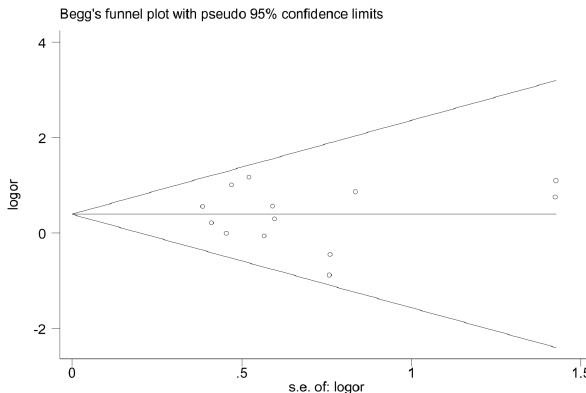
Figure 3. Begg’s funnel plot to detect publication bias in studies examining the MIF-173G/C polymorphism (CC vs . CG +